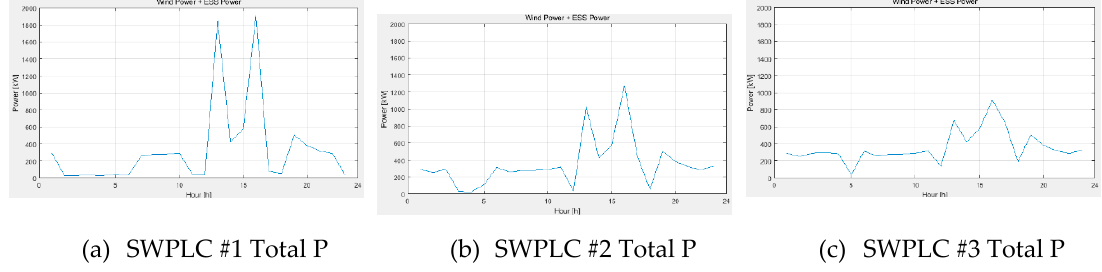
Figure 7. Hourly wind and energy storage system (ESS) power (in Scenario 3).